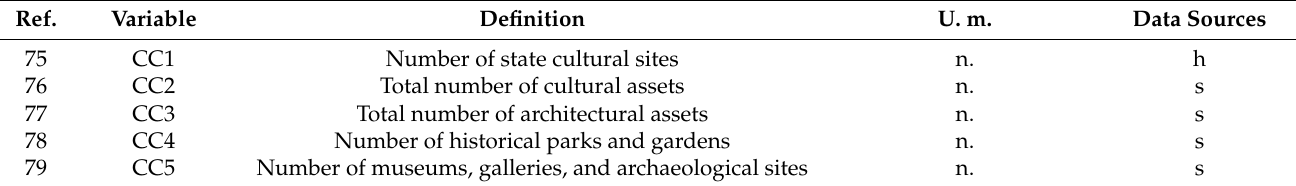
Table 6. Cultural capital indicators.